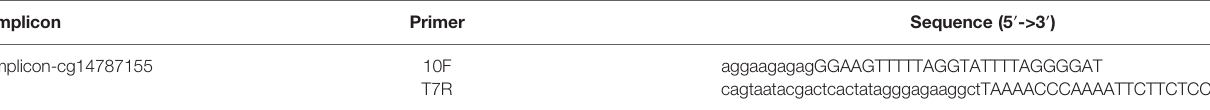
TABLE 7 | Sequence of MassARRAY primer and position relative to amplicon-cg14787155